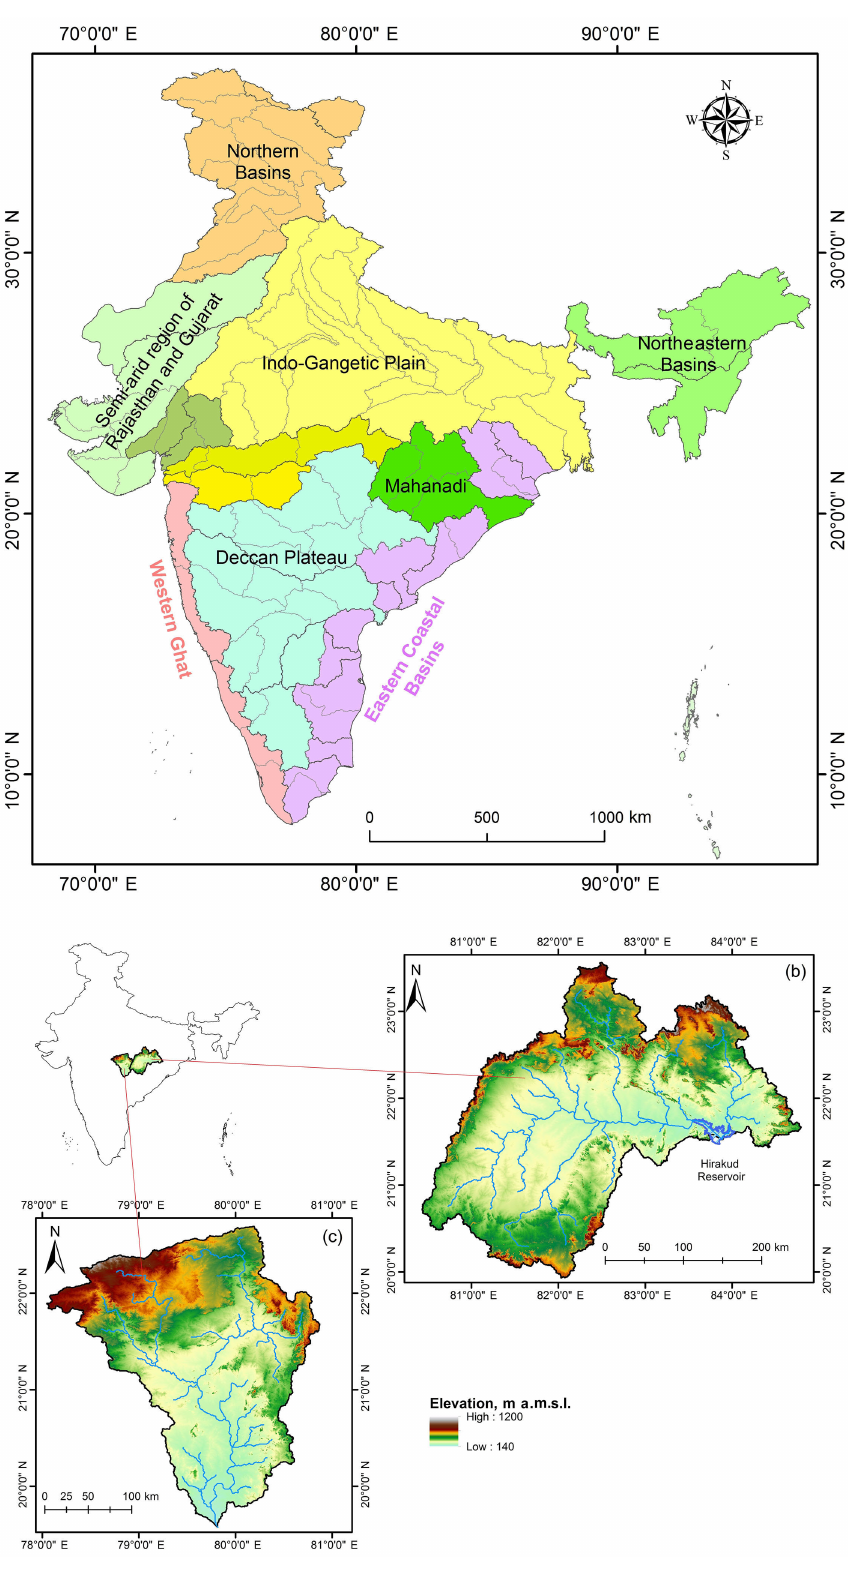
Figure 1. (a) Map of the major basins in India including west and east flowing rivers, (b) map of the Hirakud catchment of the Mahanadi River basin and (c) Wainganga catchment of the Godavari River